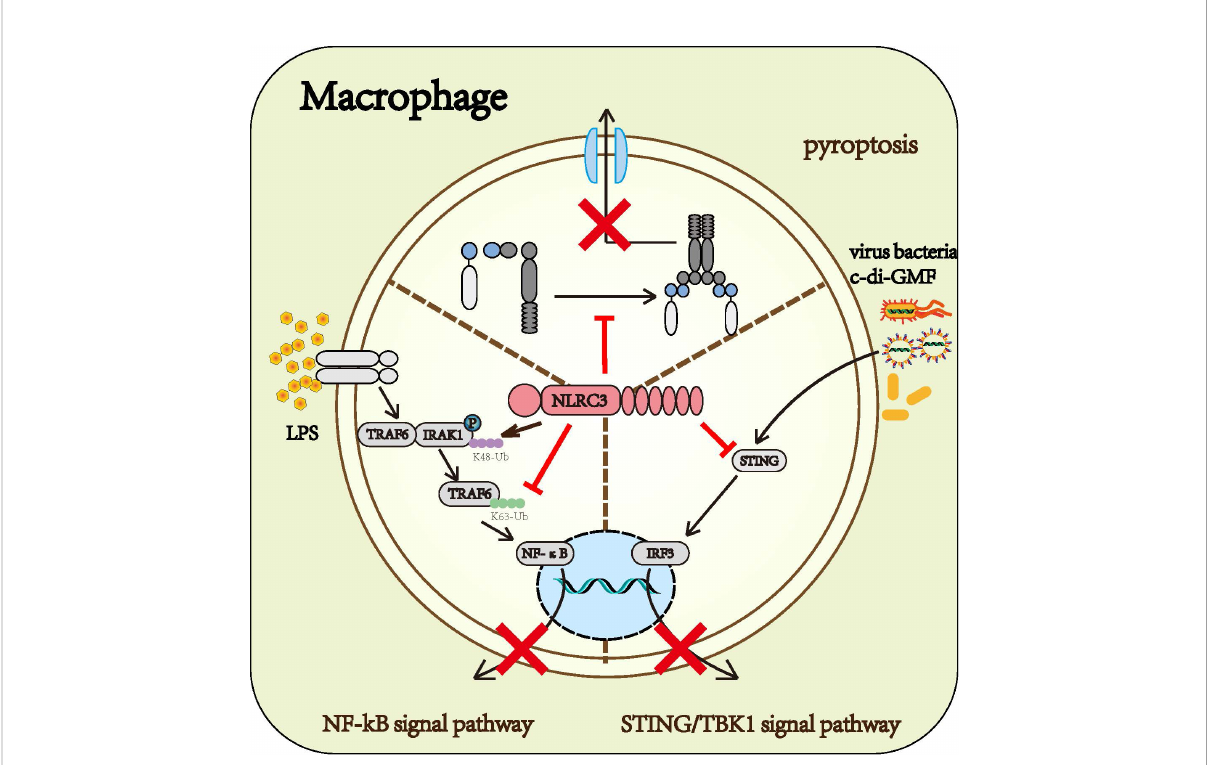
FIGURE 4 Roles of NLRC3 on macrophage: Upon the infection of gram-negative bacteria, NLRC3 decreases the activation of the NF- k B signal pathway and the release of multiple in fl ammatory cytokines such as TNF- a and IL-6 by TRAF6-dependent manner. Upon the infection of the virus, NLRC3 prevents the activation of STING/TBK1 signal pathway and the following release of I-IFN through inhibiting STING and TBK1 from functioning normally. Upon the PAMPs stimulation, NLRC3 competitively binding ASC and pro-CASP1 with NLRP3 prevents the formation of in fl ammasome and